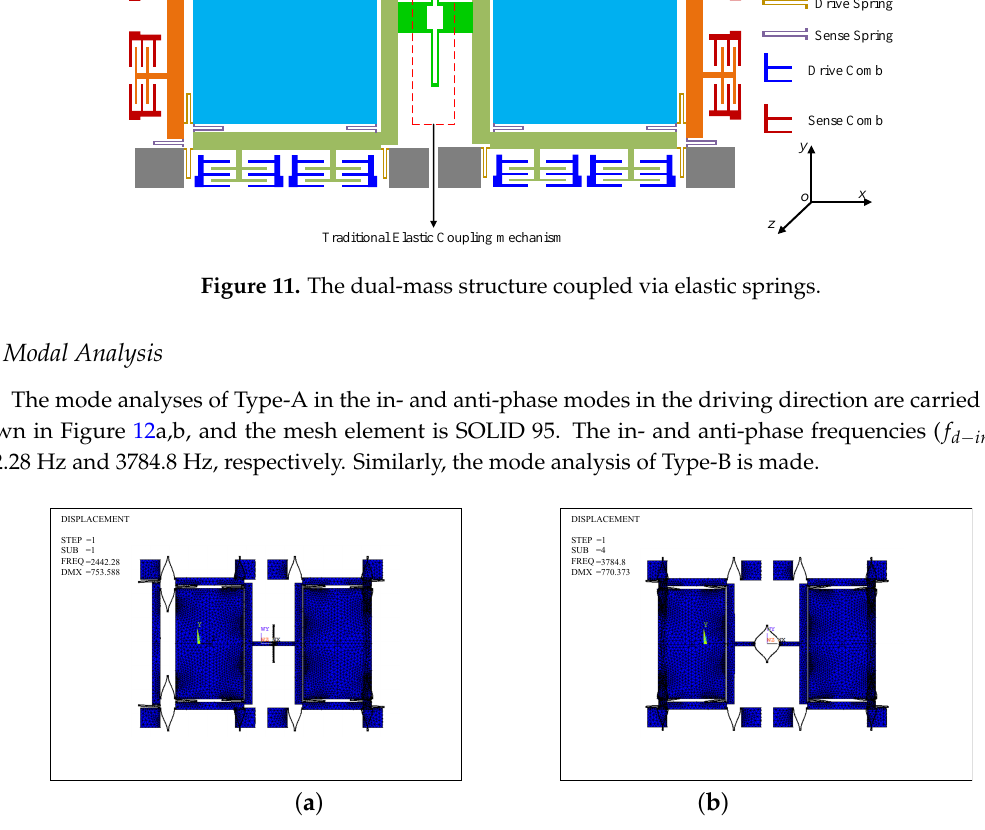
Figure 12. Modal analysis of the Type-A structure: ( a ) the in-phase mode; ( b ) the anti-phase